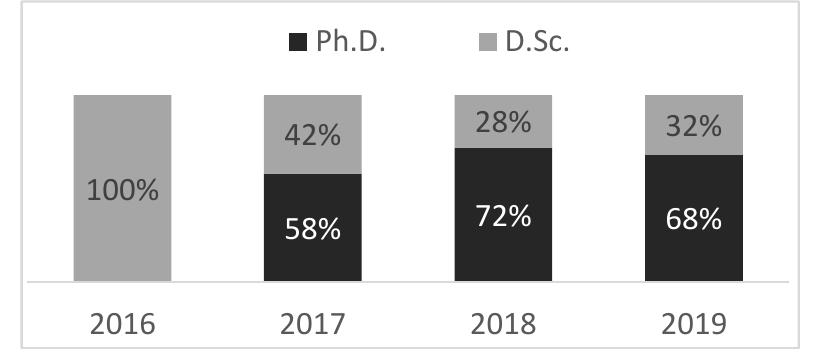
Figure 2. Percentage of academics who obtained D.Sc. compared to Ph.D.